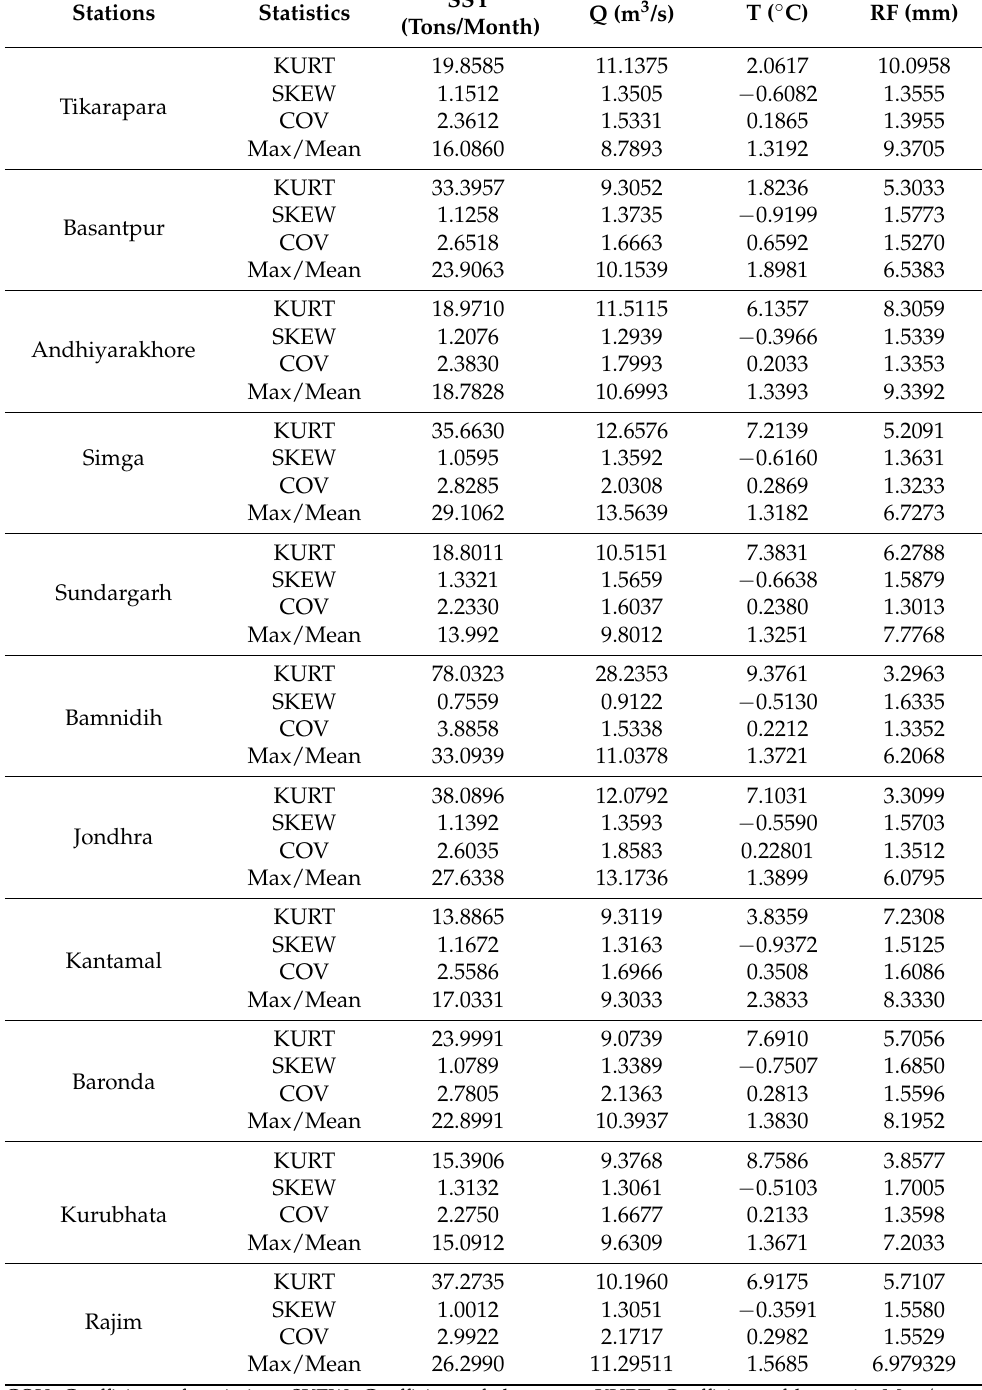
Table 2. The statistical parameters of hydro-climatic data in the Mahanadi River basin.